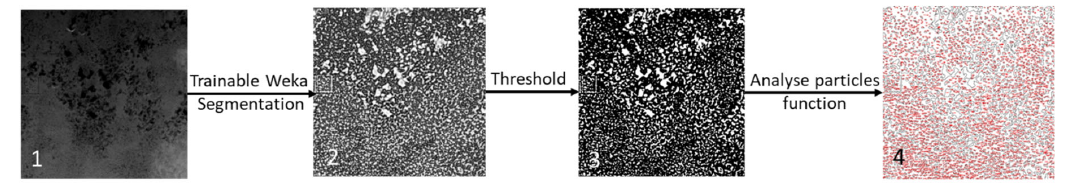
Figure 8. Protocol of image processing for the porous texture analysis of the CP layers. The dataset obtained from the image analysis with the protocol presented previously was used to perform statistical analysis of pore size distribution considering that images of the pores have disk shapes. Figures 9 and 10 present the disk (pore) size distribution of GP and NaF ‐ GP, respectively, and the Table 3 the porosity, the mean, and the median pore size obtained with this procedure. The totality of the results obtained by statistical analysis of the dataset from image analysis can be found in Supplementary Materials (Table S1).